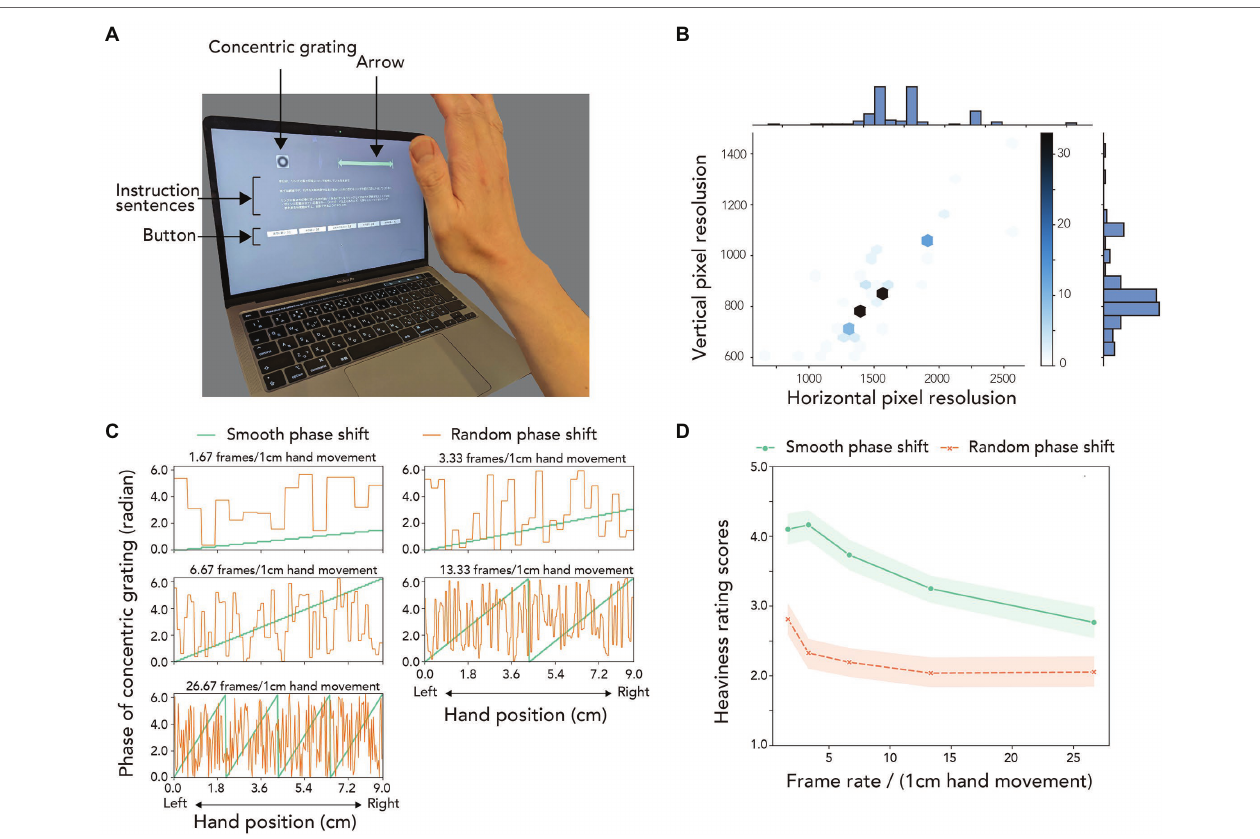
FIGURE 3 | Setup, parameters, and results of Experiment 5. (A) A snapshot of the experimental scene of Experiment 5. (B) Distribution of horizontal and vertical pixel resolutions of the computer monitors used by the experimental participants to perform the task. The color of the hexagons indicates the number of monitors with the corresponding horizontal and vertical pixel resolutions. (C) Variation of the phase of grating with hand position for the smooth and random phase shift conditions. (D) Heaviness rating scores for each of the phase shift conditions as a function of the frame rate. Error stripes indicate 95%